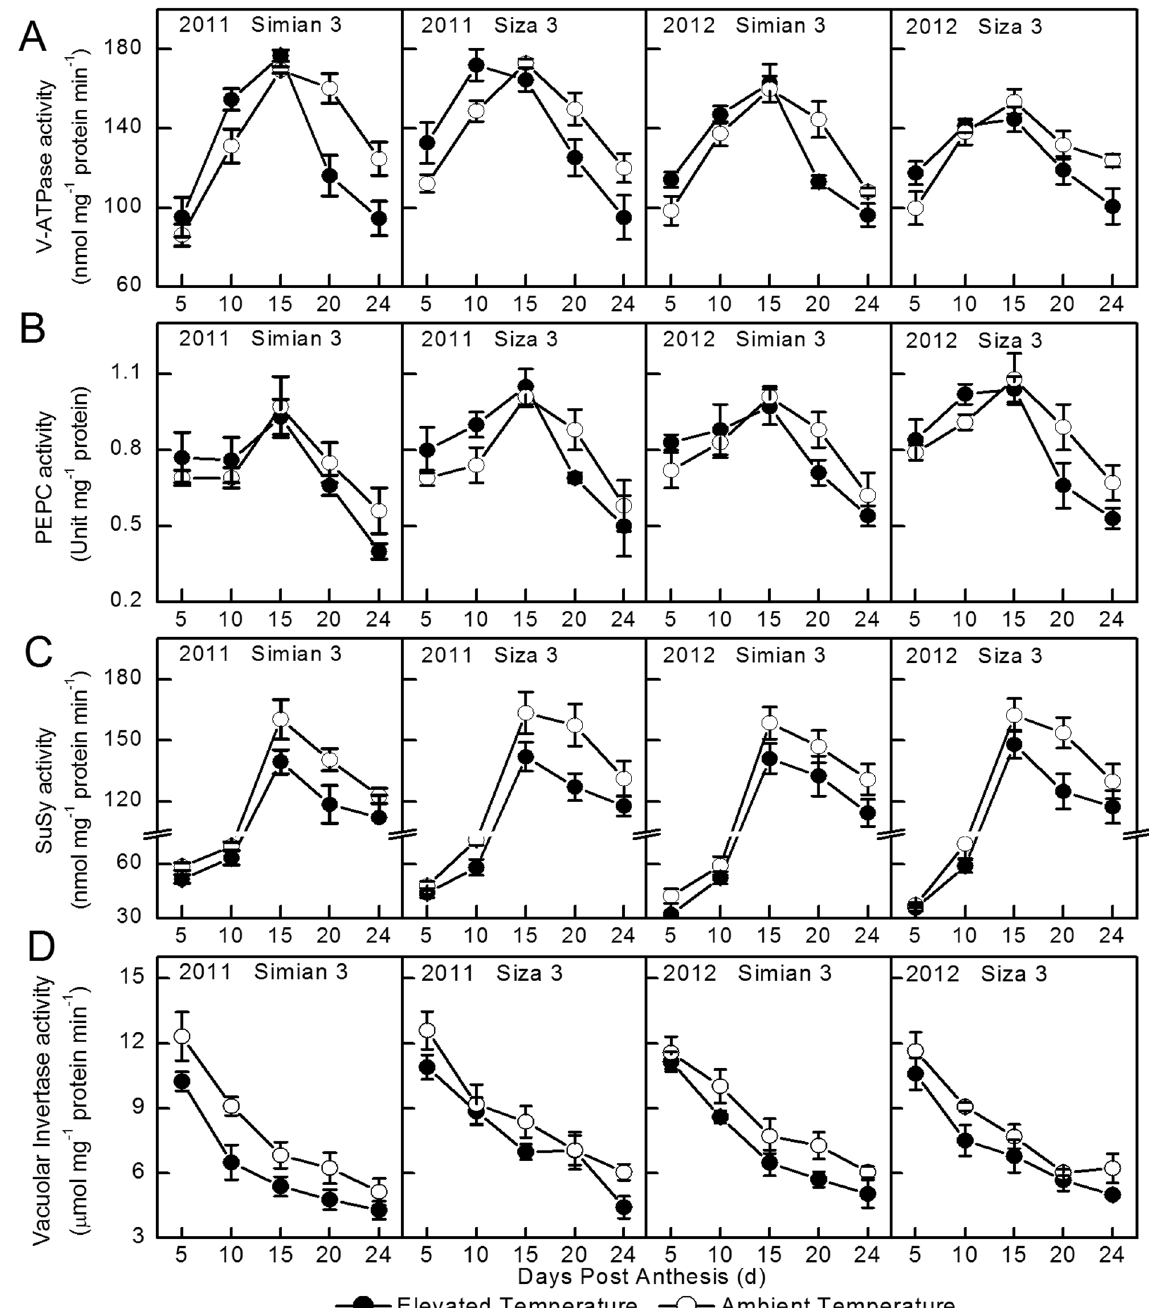
Figure 5. Dynamic changes of V-ATPase ( A ), PEPC ( B ), SuSy ( C ) and VINV activities ( D ) in cotton fiber in two temperature regions. Each data point represents the mean ± SE of three biological